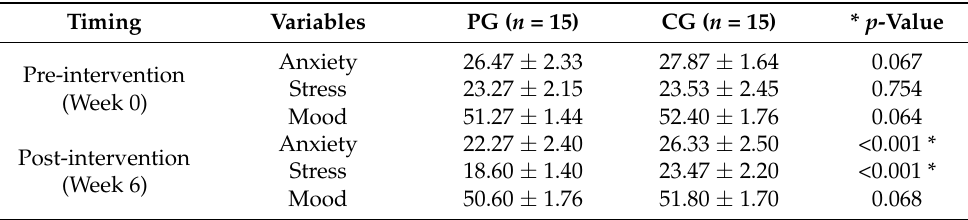
Table 5. Comparison of anxiety, stress and mood between PG and CG at pre- and post-intervention.